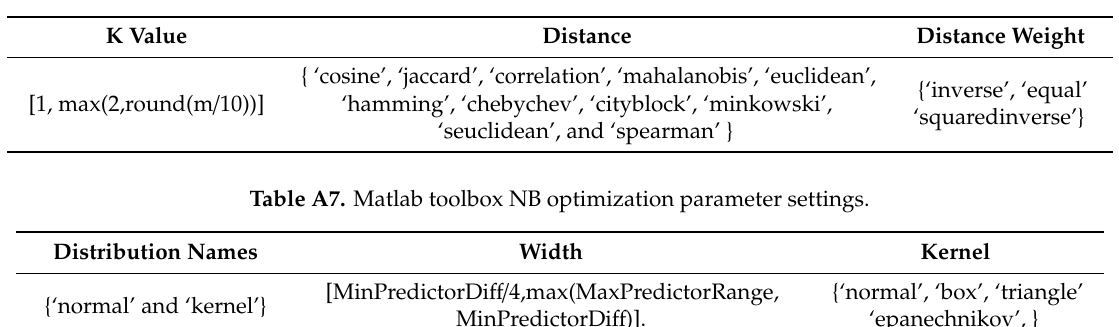
Table A6. Matlab toolbox KNN optimization parameter settings.